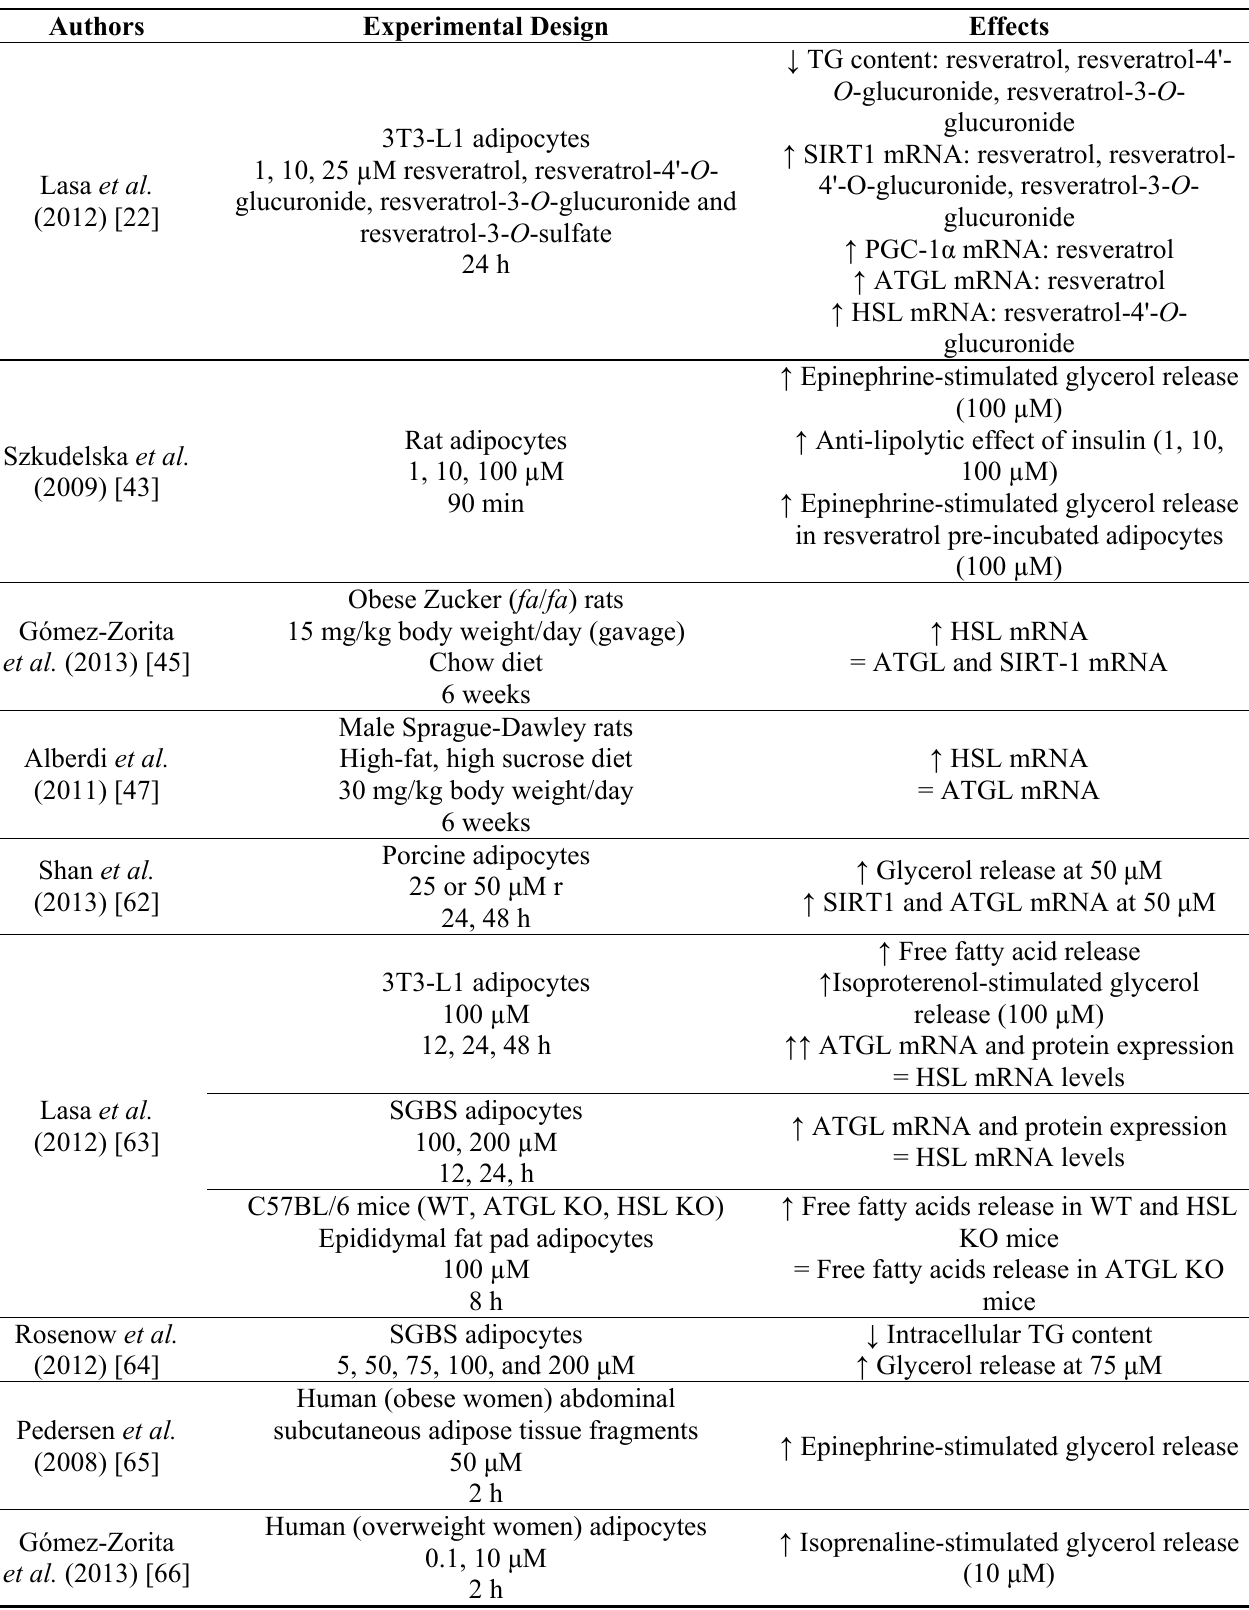
Table 4. Effects of resveratrol on lipolysis in in vitro and in vivo